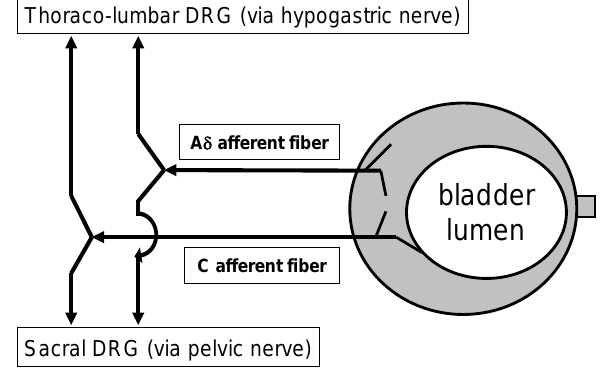
Figure 1. Diagram showing the afferent pathways from the urinary bladder. DRG, dorsal root ganglia.